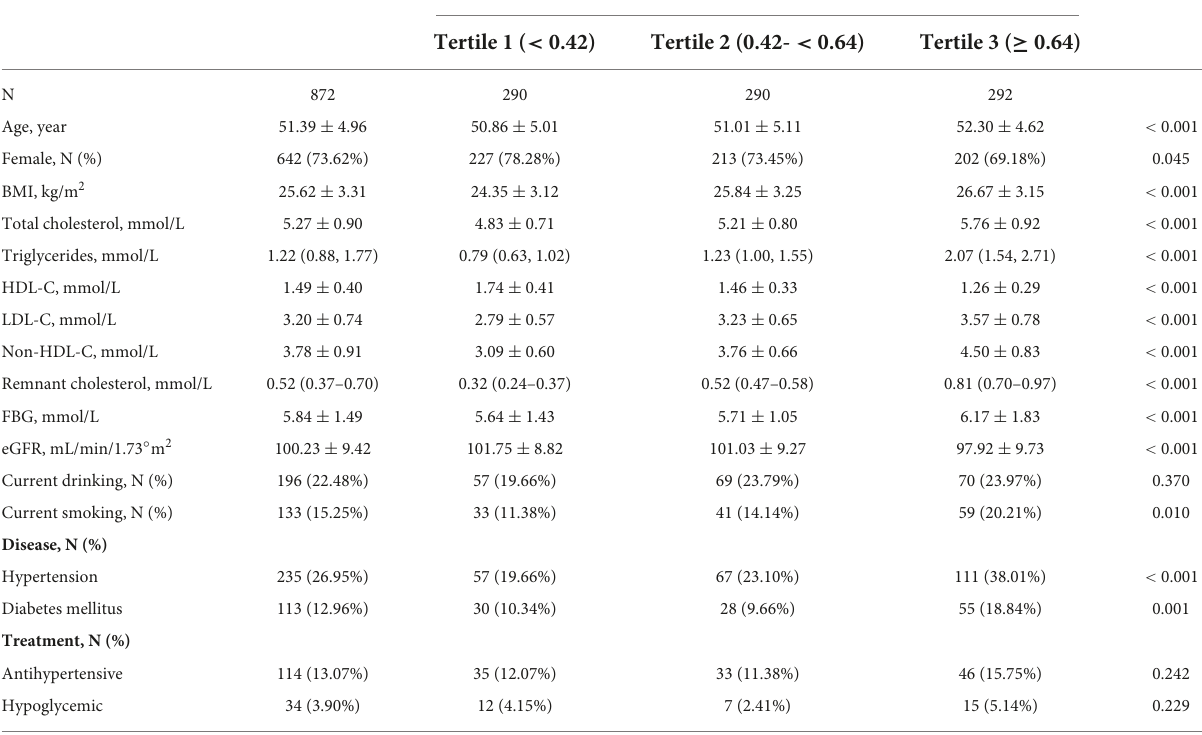
TABLE 1 Baseline characteristics stratified by remnant lipoprotein cholesterol (RC)